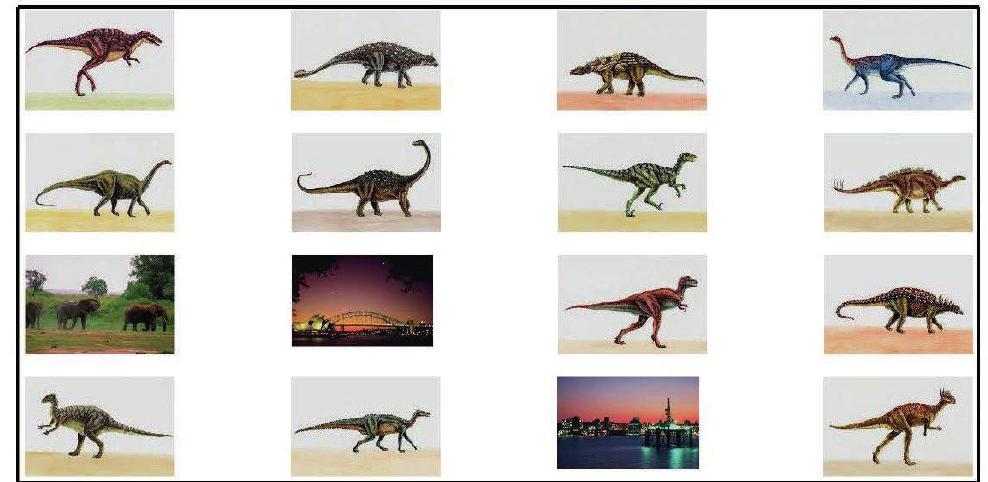
Fig. 8. Dinosaur images retrieved using EHD based CBIR.